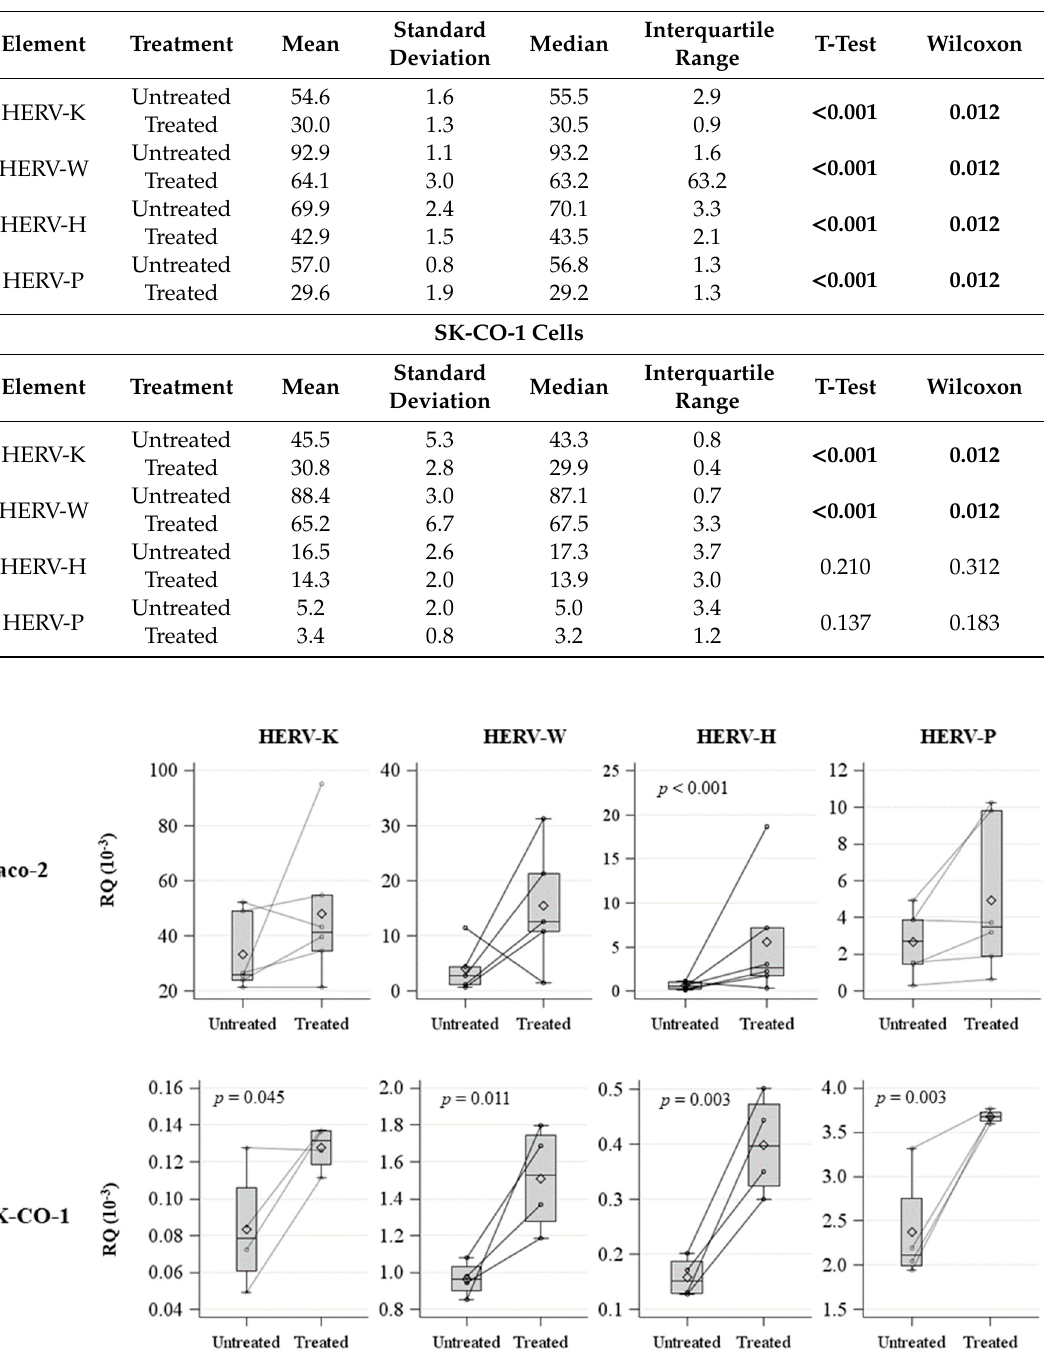
Figure 2. Spaghetti plot and box plot of HERV-H, HERV-K, HERV-W, and HERV-P expression levels (RQ 10 − 3 ) in untreated and decitabine-treated Caco-2 and SK-CO1 cells.